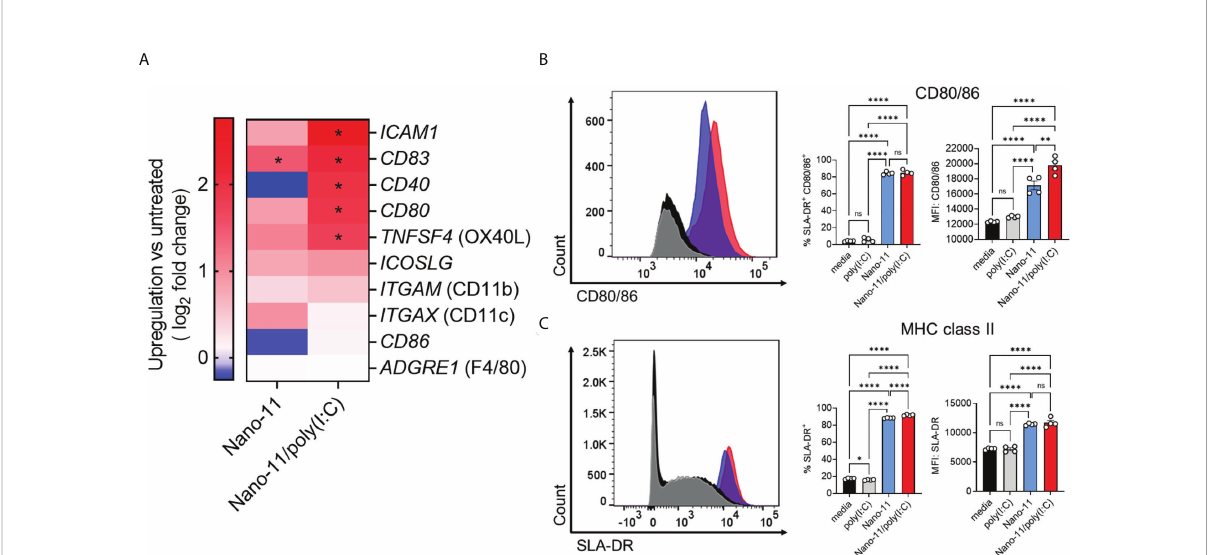
FIGURE 4 Regulation of costimulatory and MHC class II molecule expression by Nano-11 or Nano-11/poly(I:C). (A) Heat map comparing mRNA expression fold changes for costimulatory molecules and DC markers in porcine Mo-DCs following stimulation with Nano-11 or Nano-11/poly(I:C) compared to untreated porcine Mo-DCs. Red denotes genes with high expression levels, and blue denotes genes with low expression levels. For each experimental group the results from three different animals are shown. * indicates a signi fi cant change in gene expression at p < 0.05. (B) Flow cytometry analysis of porcine Mo-DC cell surface expression of costimulatory markers CD80/86 and (C) MHC class II (SLA-DR). The bars indicate the mean ± SE of three replicates. Results are representative of two independent experiments. *p < 0.05, **p < 0.01, ****p < 0.0001 by one-way ANOVA with Tukey multiple comparisons test. ns not statistically signi fi